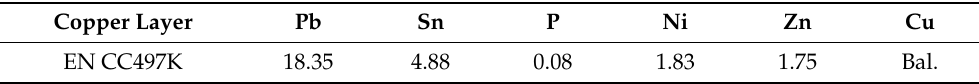
Table 1. Chemical composition of the matrix material (wt.%).